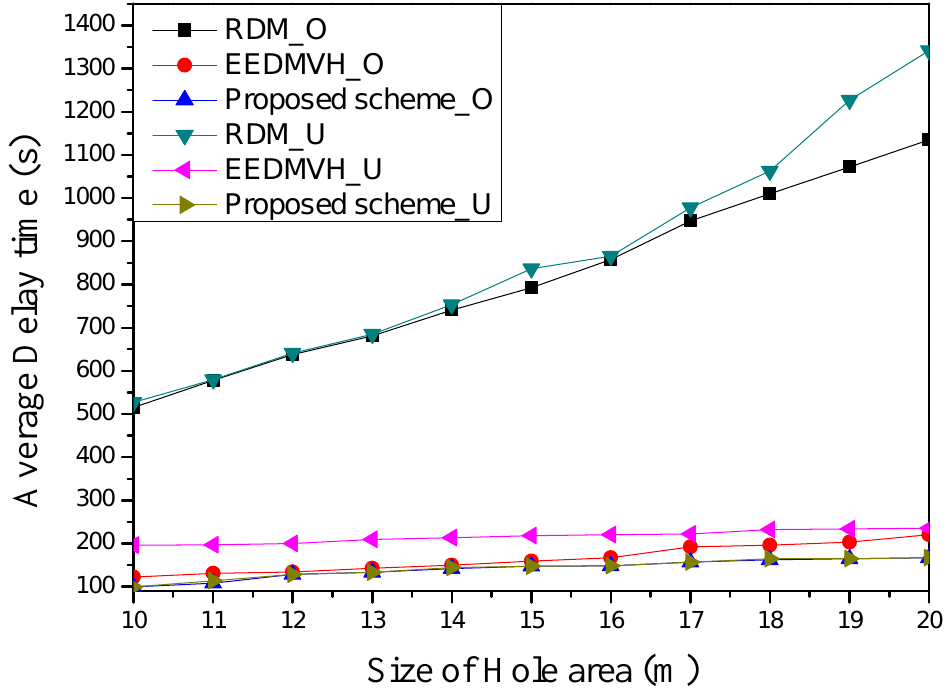
Figure 11. Average delay time according to hole